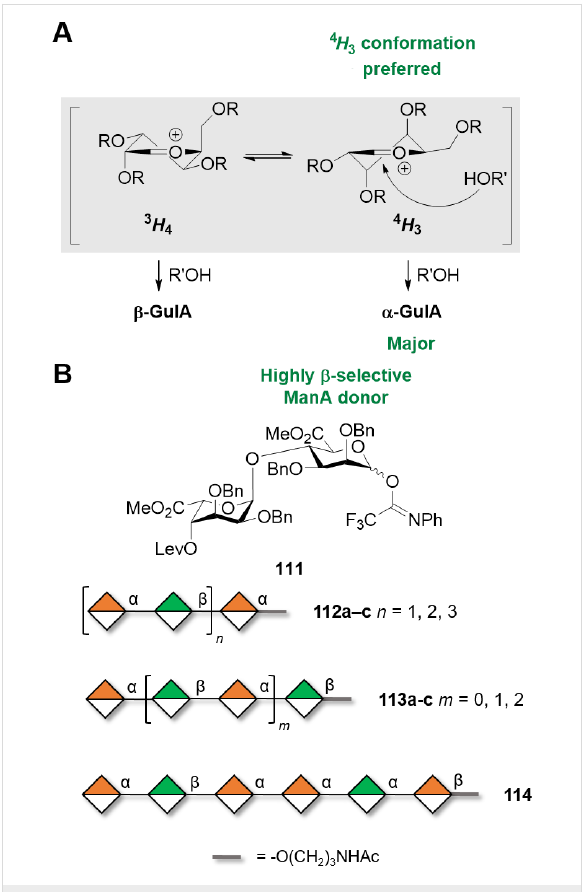
Figure 8: A) The preferred 4 H 3 conformation of the gulosyl oxocarbe- nium ion favors the attack of the alcohol from the α -face. B) Key disac- charide BB 111 used for the solution phase synthesis of alginate oligo- saccharides and representative structures